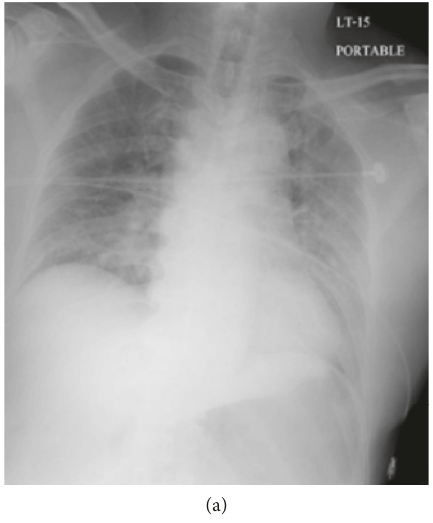
Figure 3: MES was detected in right MCA. Figure 4: